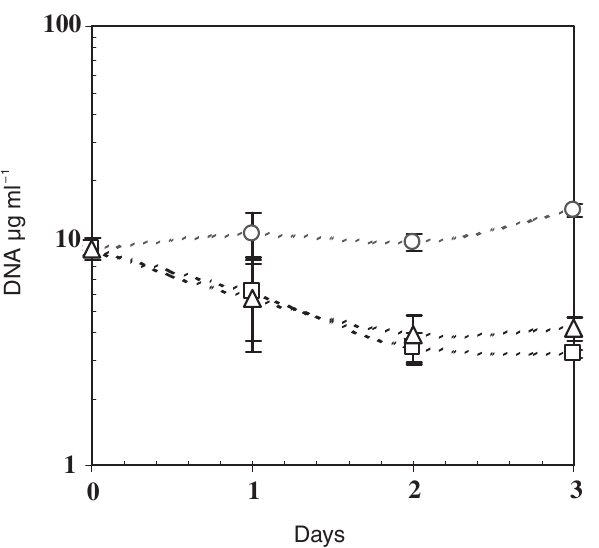
Figure 3. Effect of MoO 42– on the quantity of extractable DNA. Geno- mic DNA concentrations from F. acidarmanus cells suspended in 0.1% yeast extract acidified to pH 1.0 with H 2 SO 4 ( (cid:3) ) and with the addition of 5 mM ( (cid:5) ) or 20 mM ( (cid:6) ) MoO 42– . All values represent means of three trials. Error bars represent the standard error of the mean.